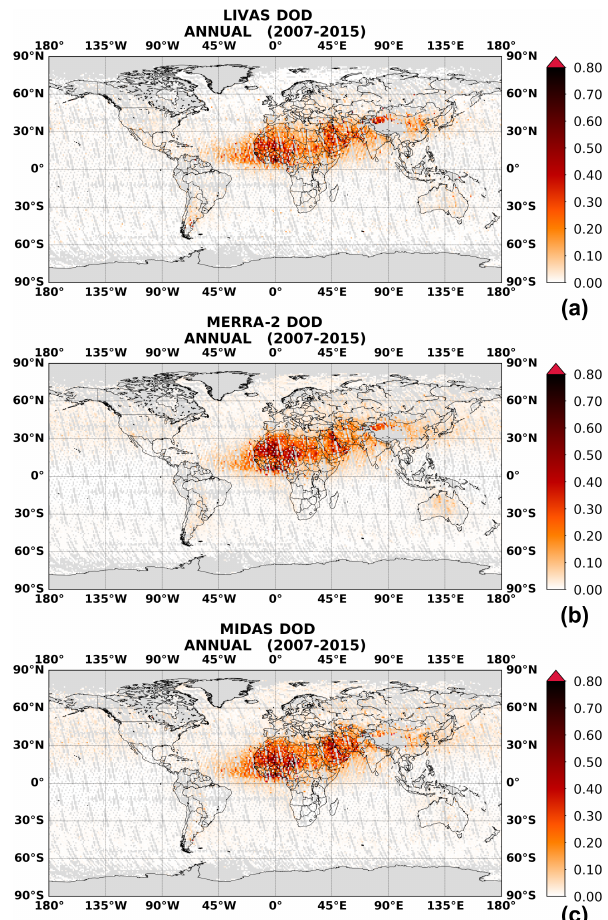
Figure 5. Long-term (2007–2015) average geographical colocated distributions at 1 ◦ × 1 ◦ spatial resolution during daytime for (a) LI- VAS DOD 532nm , (b) MERRA-2 DOD 550nm , and (c) MIDAS DOD 550nm